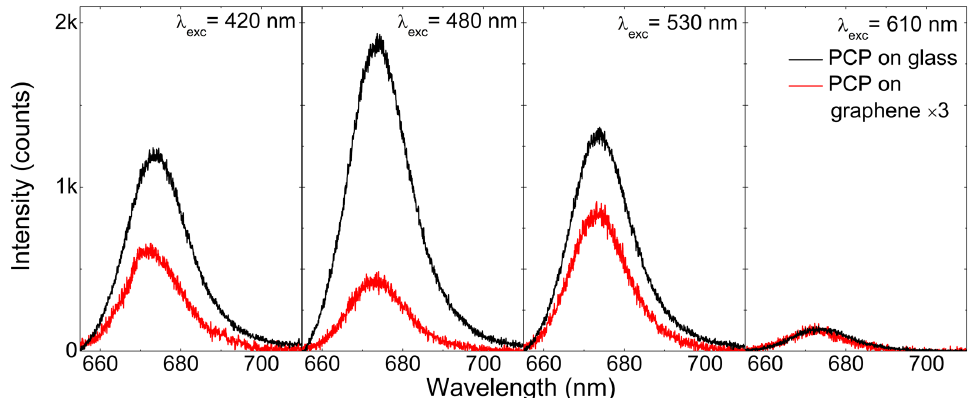
Figure 2. Emission spectra of PCP deposited on glass (black lines) and on graphene substrate (red lines) when excited at different excitation wavelengths. For better comparison, results collected on graphene were multiplied by a factor of 3.